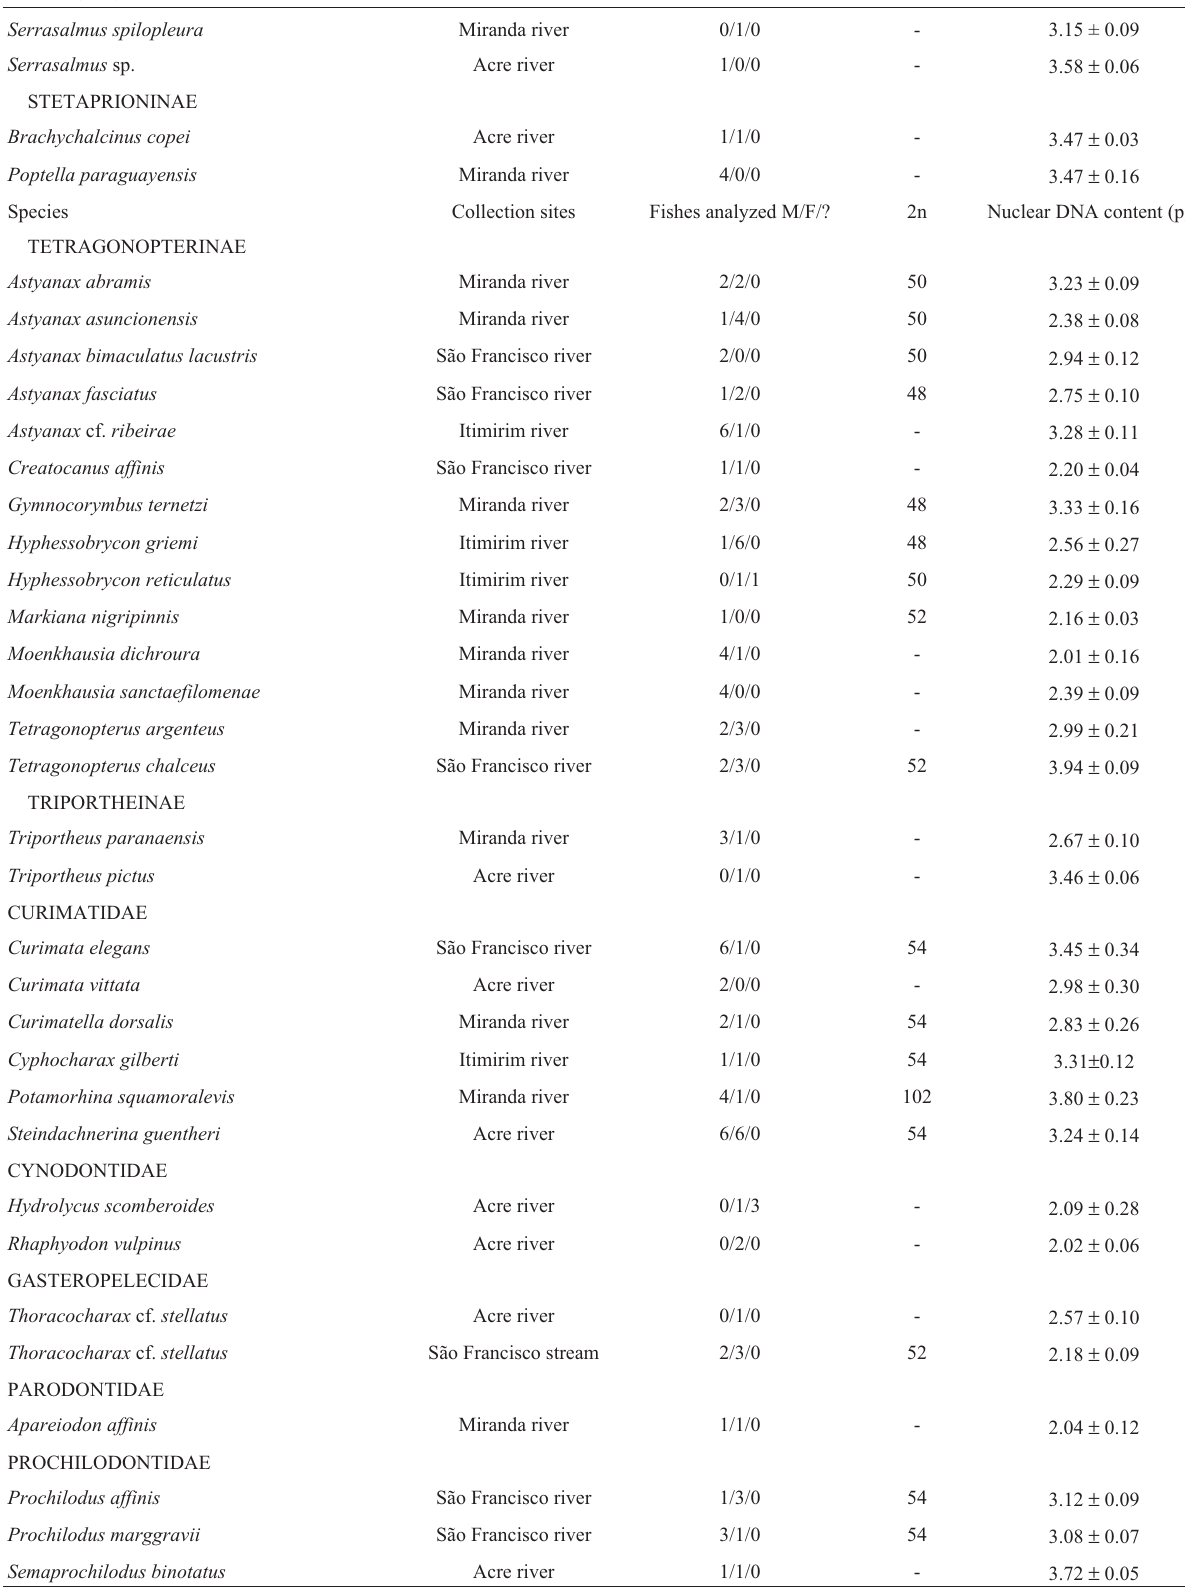
Table I. (cont) Serrasalmus